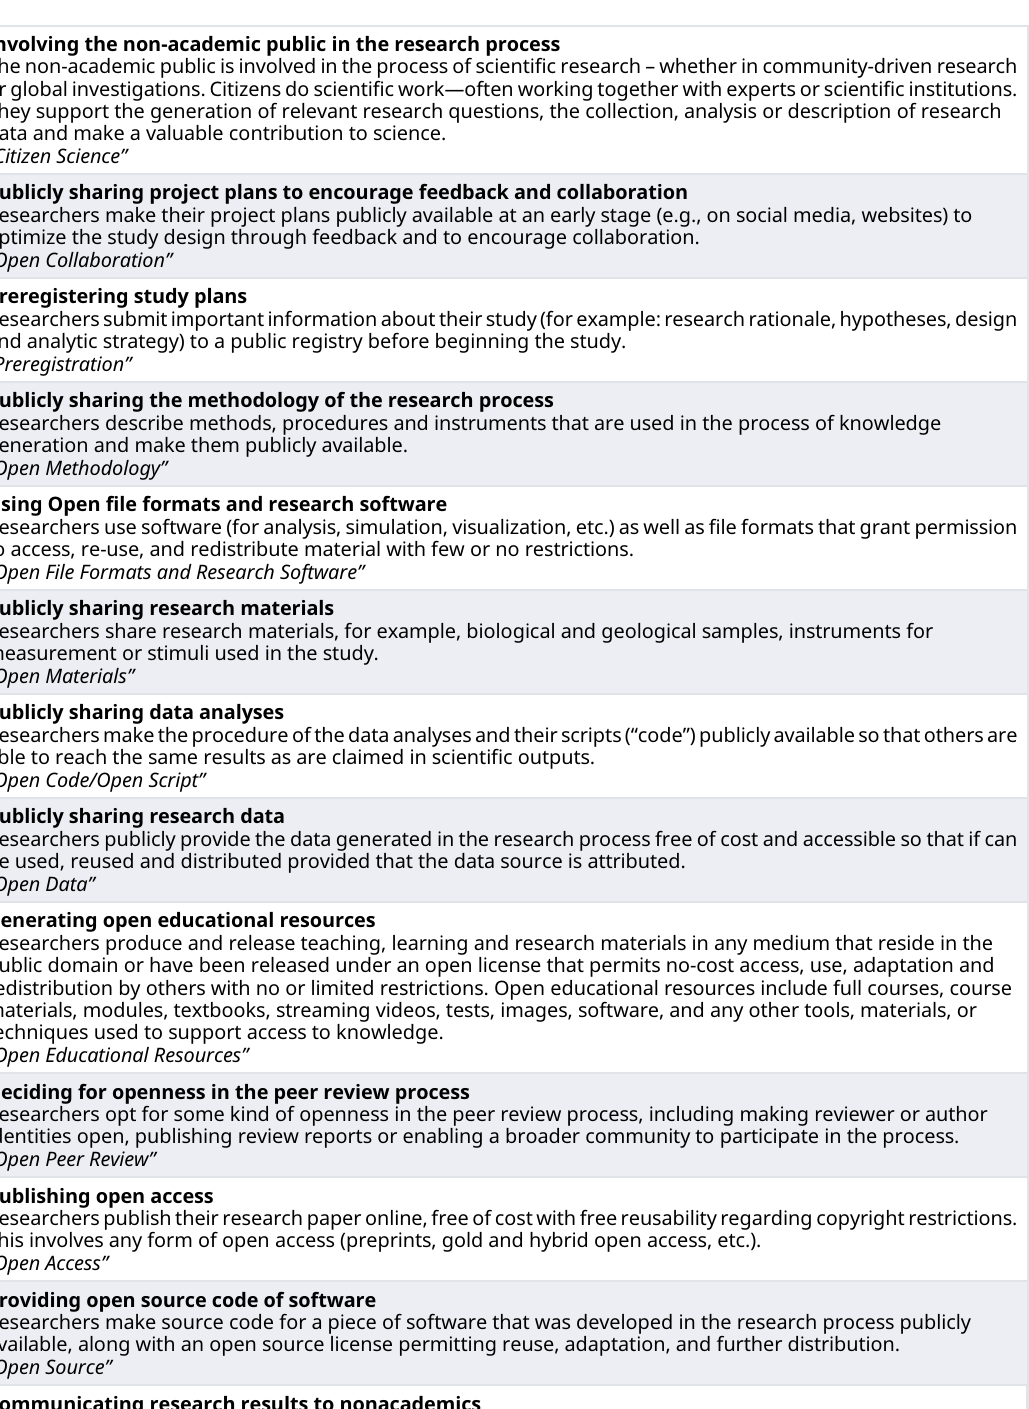
Table 2. The items of the 13 open science practices addressed in the